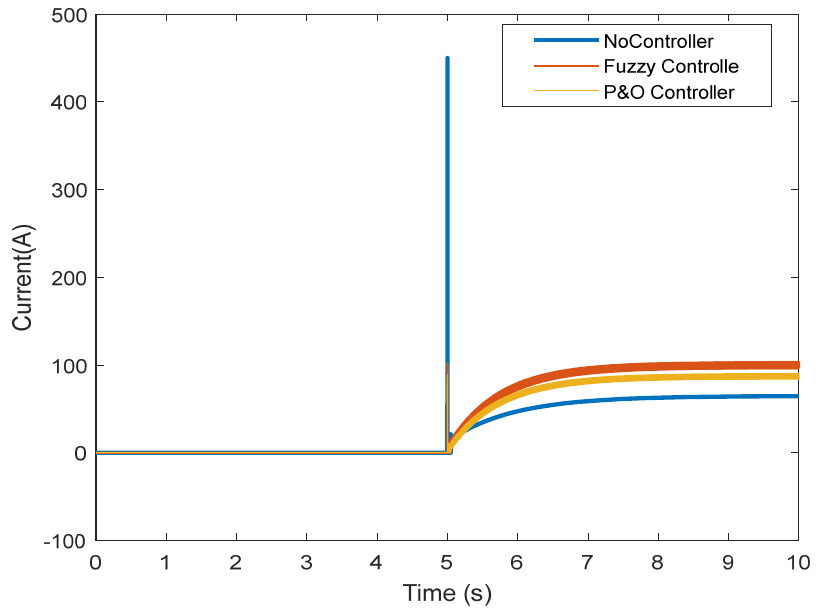
Figure 16. Output current of the fuel cell in the transient state.